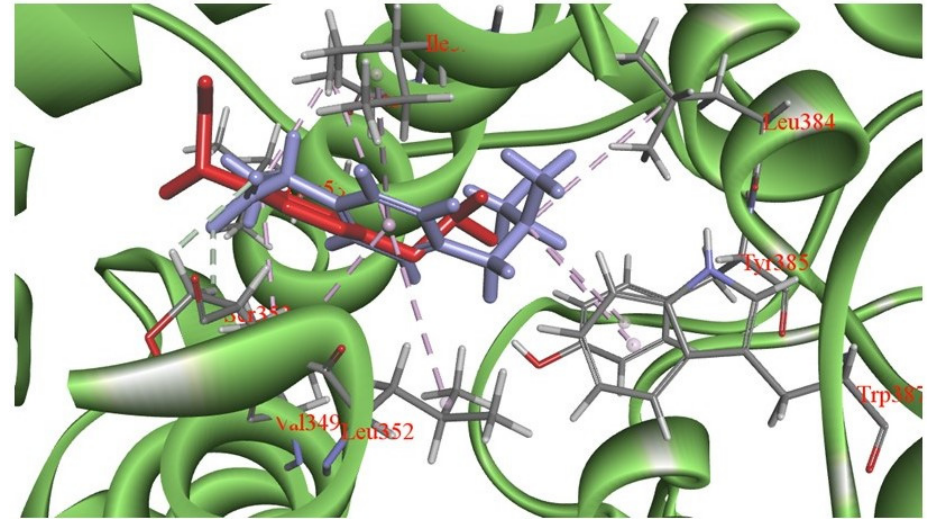
Figure 13. Overlaying of the two ibuprofen poses originating from that retrieving from PDB data base (1EQG) and from that of the docking result. Original pose from PDB specified in blood red and the pose from docking result marked in purple. RMSD = 5.649 Å .